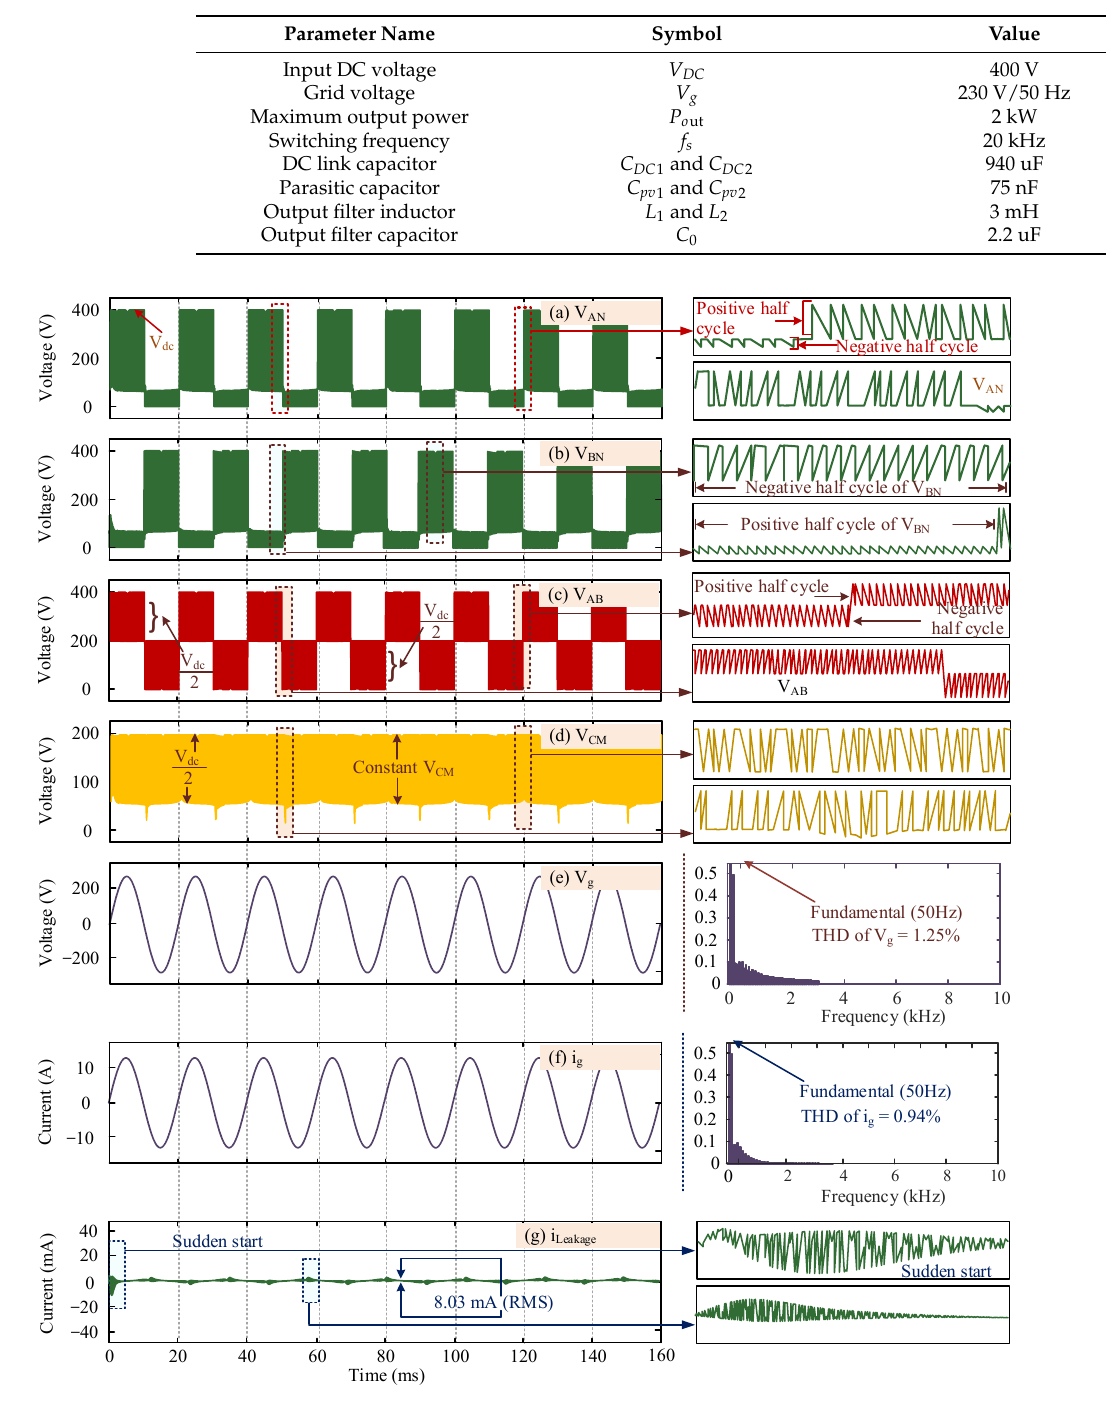
Figure 10. Simulation results for the proposed transformer-less inverter: ( a ) V AN , ( b ) V B N , ( c ) V C M , ( d ) V AB , ( e ) grid voltage V g and its THD, ( f ) grid current i g and its THD, and ( g ) leakage current i Leakage .